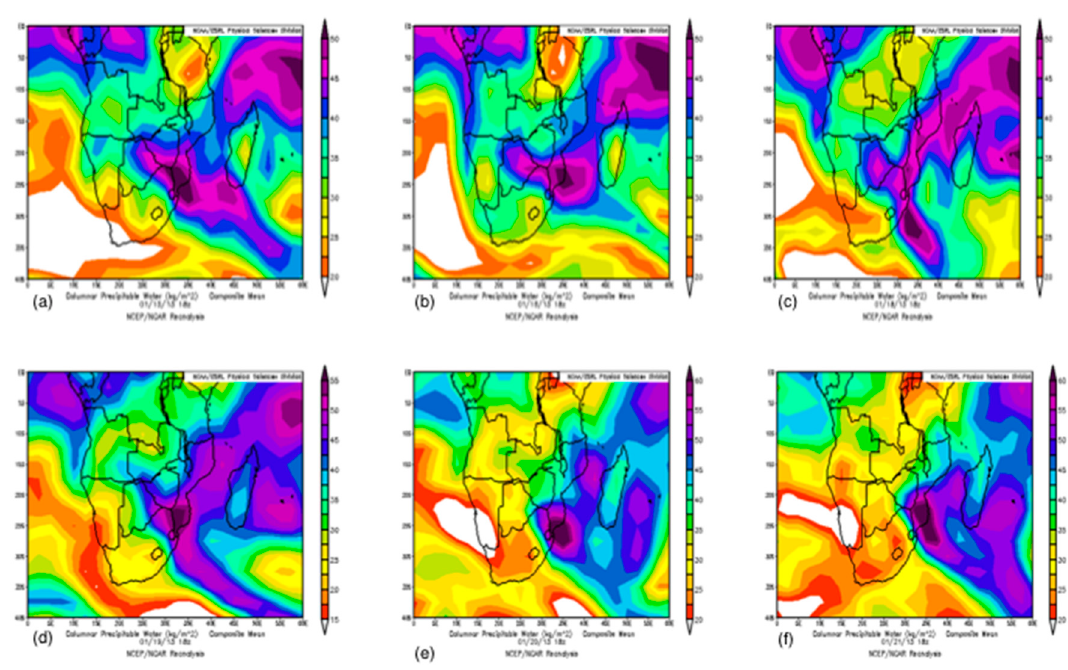
Figure 11. NCEP / NCAR re-analysis surface precipitable water (kg m − 2 ) at 925 mb (https: // www.esrl. Figure 11 . NCEP/NCAR re-analysis surface precipitable water (kg m -2 ) at 925 mb noaa.gov / psd / data / composites / hour / ). Precipitable water composites on 15 ( a ), 16 ( b ), 18 ( c ), 19 ( d ), 20 (https://www.esrl.noaa.gov/psd/data/composites/hour/). Precipitable water composites on 15 ( a ), 16 ( e ) and 21( f ) January ( b ), 18 ( c ), 19 ( d ), 20 ( e ) and 21( f ) January 2013.